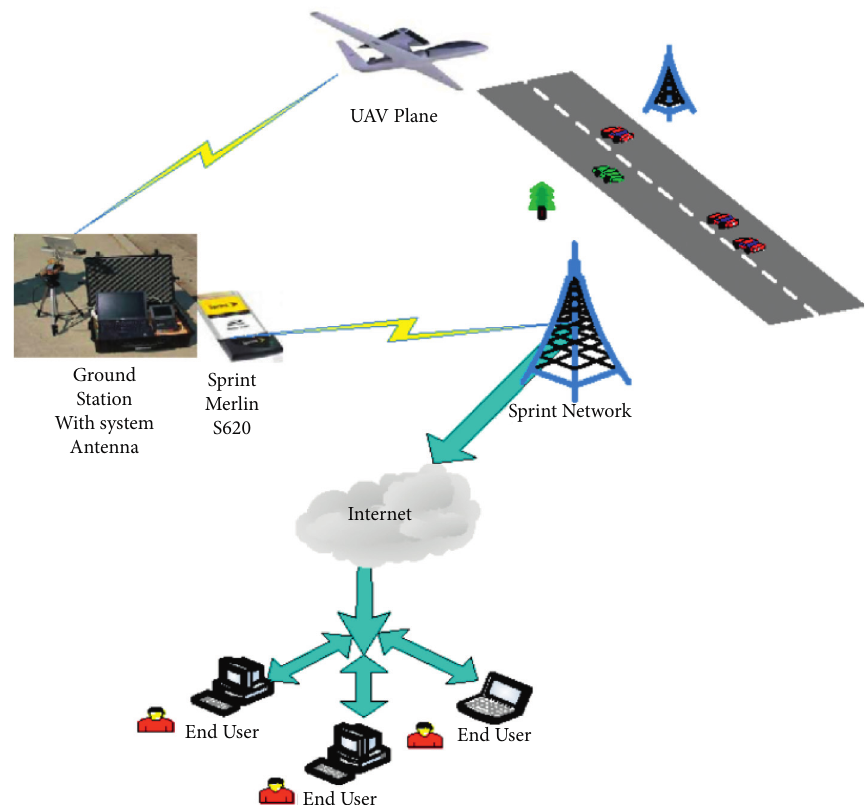
Figure 1: A typical UAV traffic surveillance